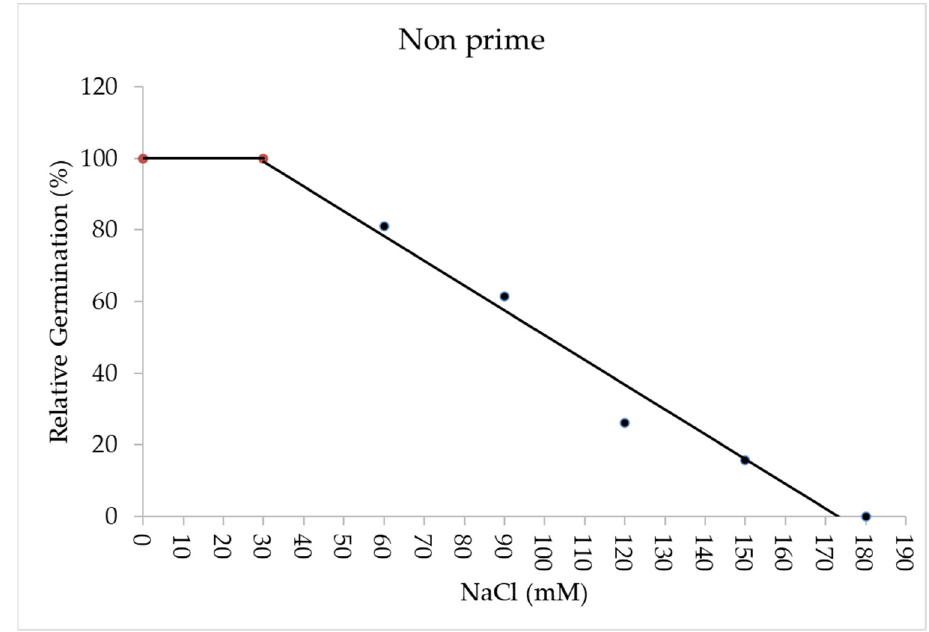
Figure 5. Hibiscus tea relative germination response to increasing salinity in non-primed seeds.